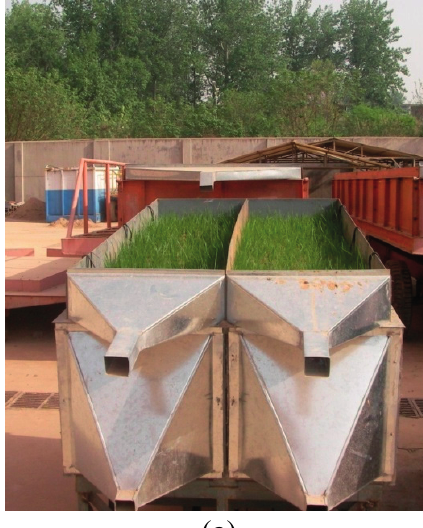
( b ) the structure of the experimental plots and soil water measurement